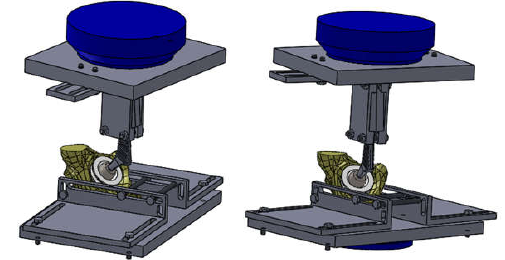
Figure 16. The fixing device (two spatial views).